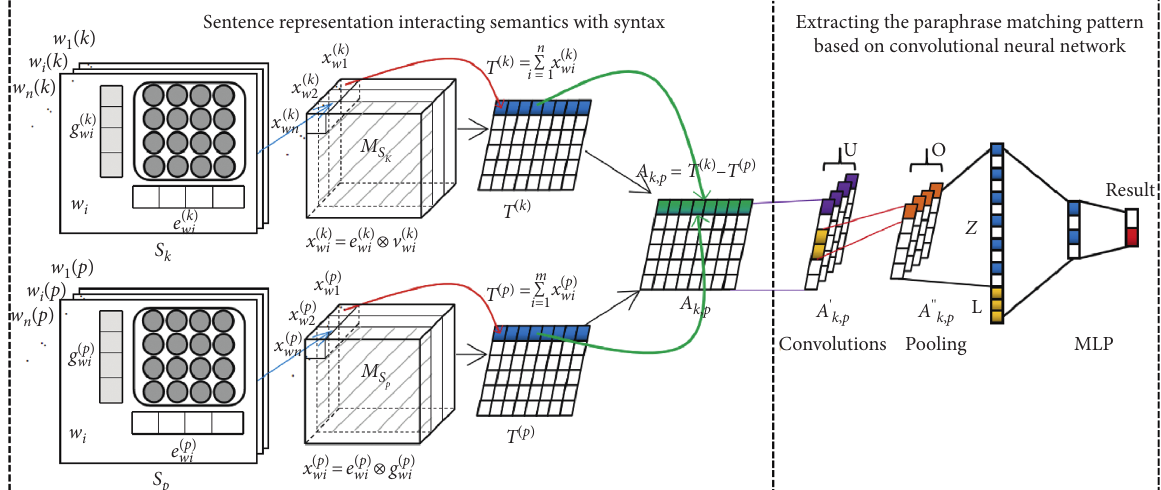
Figure 6: The architecture of the deep paraphrase identification model interacting semantics with syntax (DPIM-ISS).